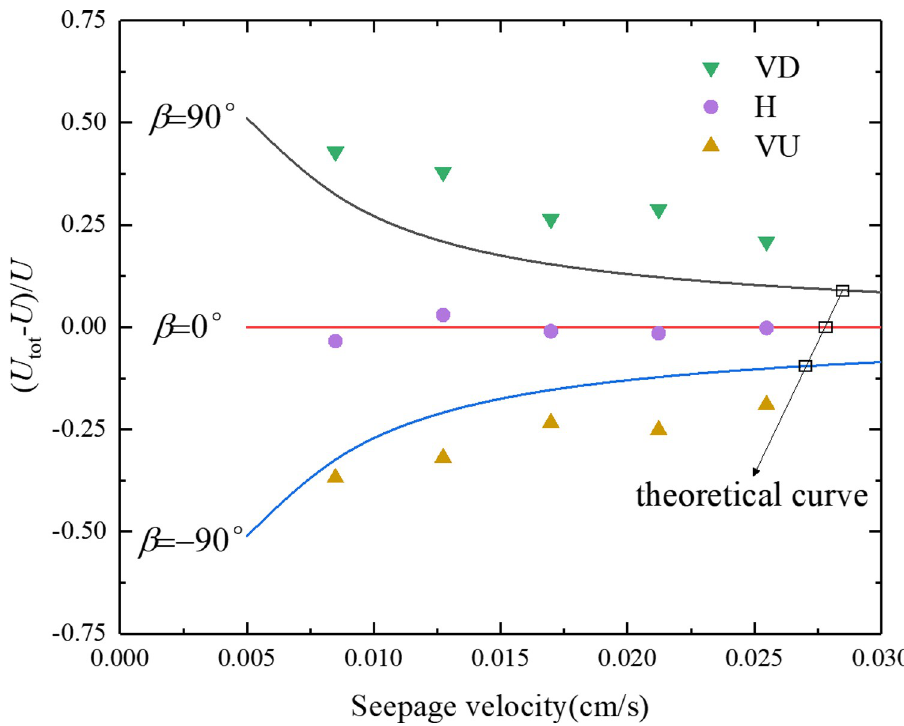
Fig 7. Relationship between the particle effective velocity and seepage velocity under three different seepage